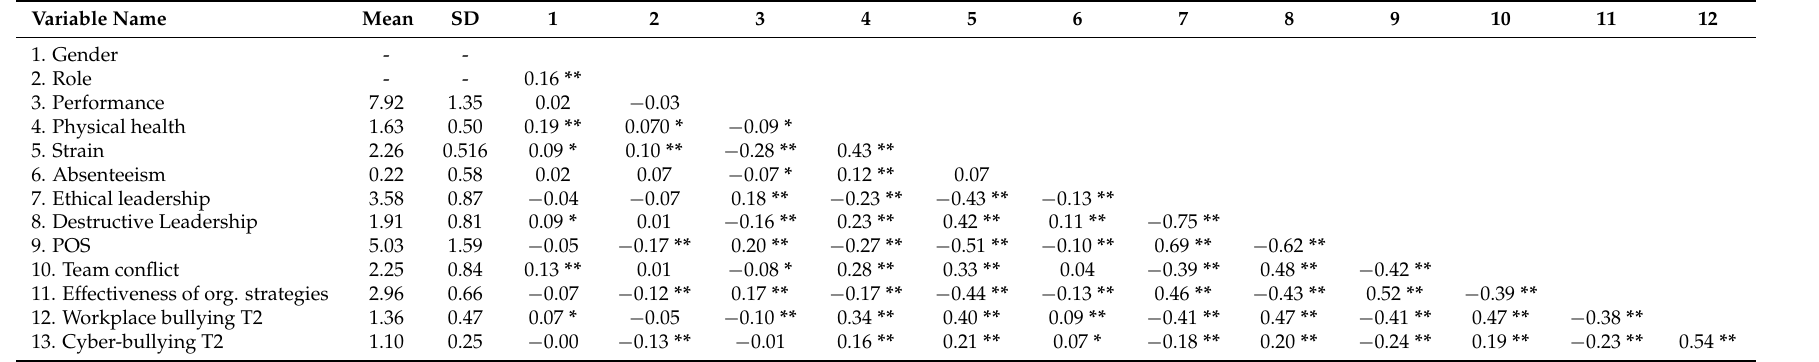
Table 1. Bivariate correlations between Time 1 variables and Time 2 workplace bullying and cyber-bullying. POS, perceived organisational